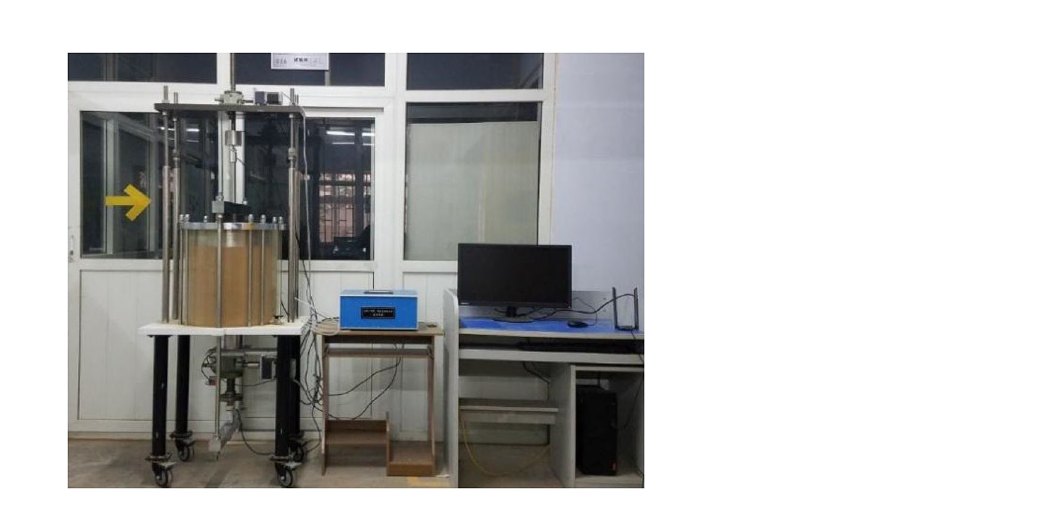
Figure 2. Model test device